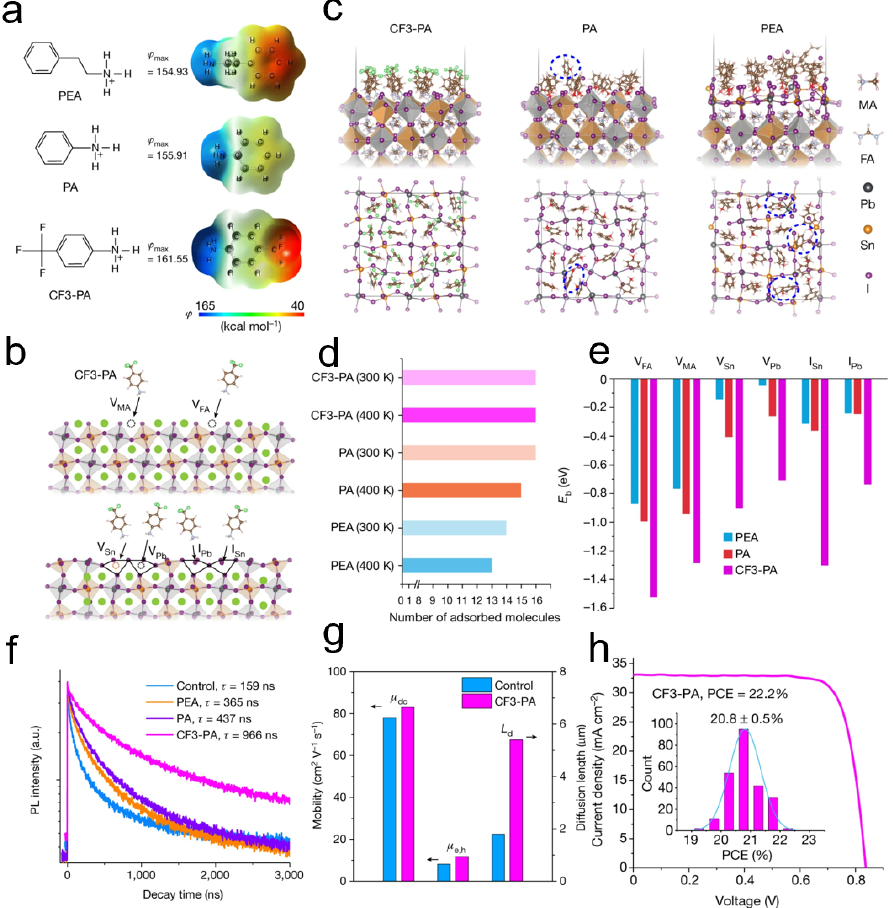
Figure 2. ( a ) The molecular structures of three passivators (PEA, PA, and CF3-PA). ( b ) Schematic diagram of the interaction between ammonium cations with the acceptor-like defects. ( c ) Ab initio molecular dynamics snapshots and top views of the CF3-PA-, PA-, and PEA-adsorbed perovskite surfaces at a temperature of 400 K. ( d ) The number of adsorbed molecules for CF3-PA, PA, and PEA at temperatures of 300 and 400 K. ( e ) The binding energy (E b ) between passivators and various ac- ceptor-like defects. ( f ) Time-resolved PL spectra of the control, PEA, PA, and CF3-PA perovskite films. ( g ) Mobilities and diffusion lengths of the CF3-PA and control Pb-Sn perovskite films. ( h ) J-V curves of the best CF3-PA device (with 1.2 μ m thick absorber). The inset shows the PCE distribution of 237 CF3-PA devices, showing an average PCE of 20.8 ± 0.5%. Reprinted/adapted with permission from Ref. [20]. Copyright 2022, Nature Publishing Group.